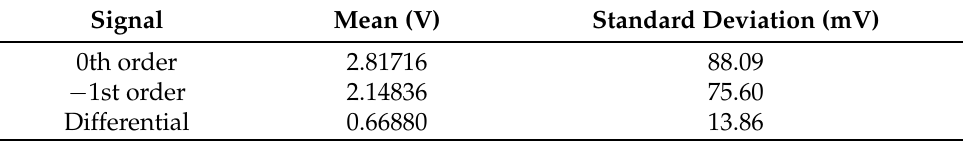
Figure 8. Time traces associated with the injection of a solution (RI of 1.3295 at λ 0 = 1312 nm) with artificial noise introduced by manipulating the syringe. Table 4. Mean (time-averaged) differential output voltage and standard deviation over time of the differential output voltage associated with the injection of a solution (RI of 1.3295 at λ 0 = 1312 nm) as shown in Figure